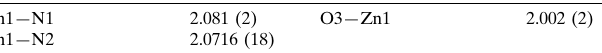
Selected bond lengths (A˚ ).